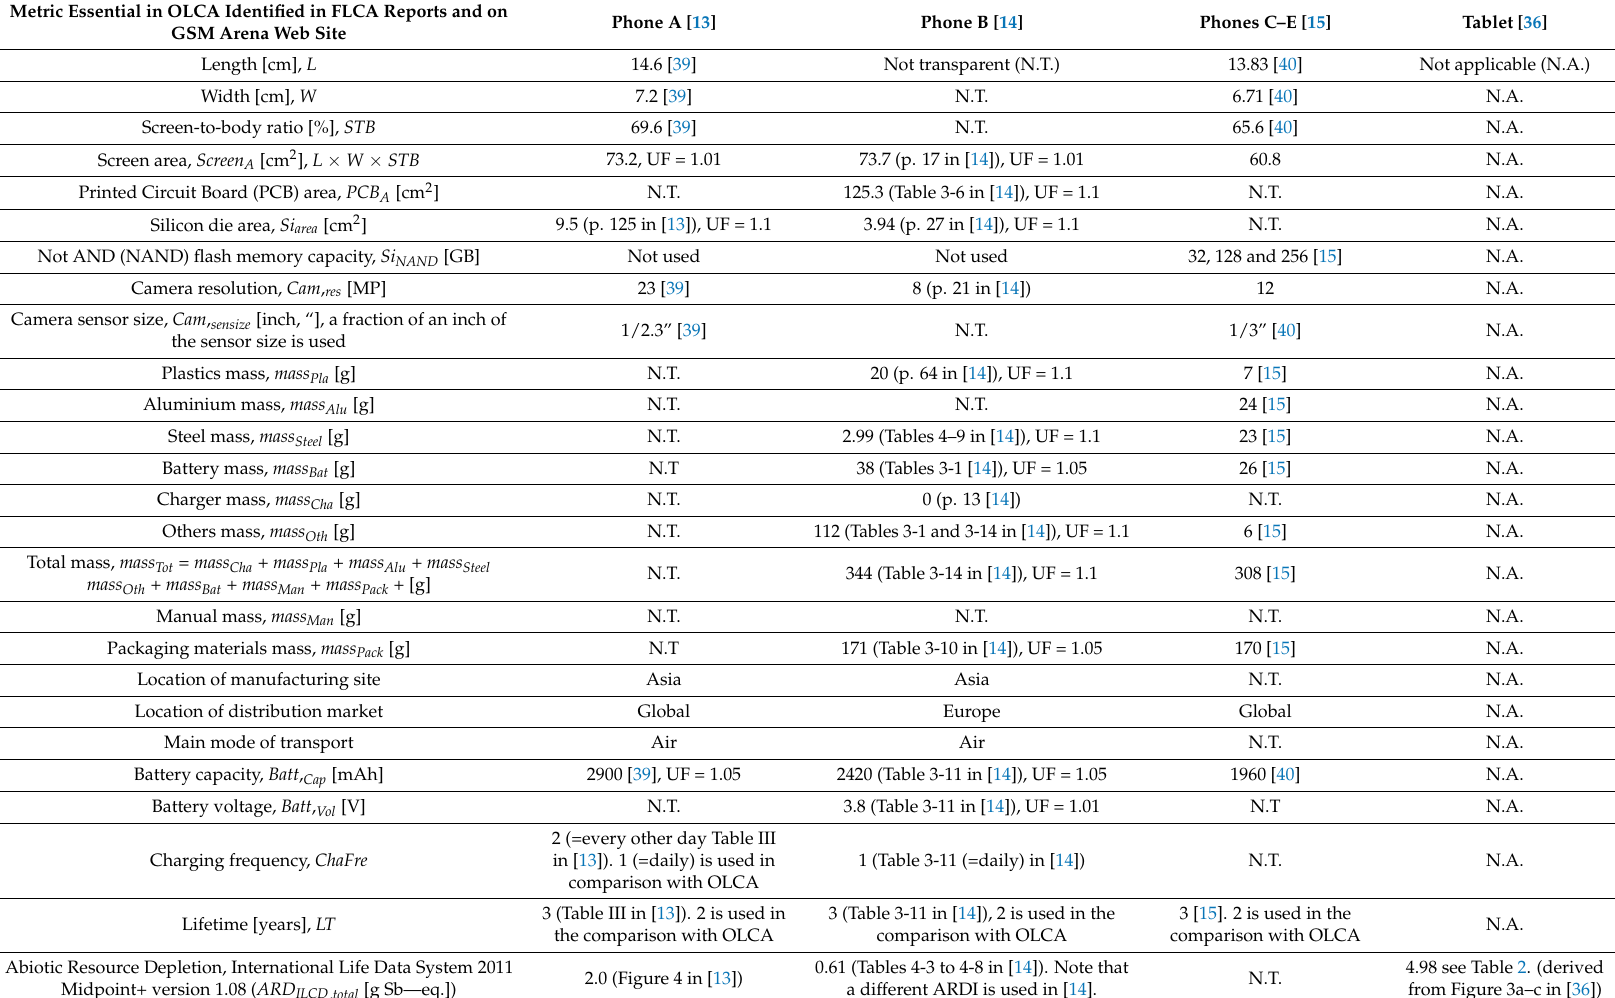
Table 4. Summary of product metrics useful for comparing the reliability of OLCA compared with